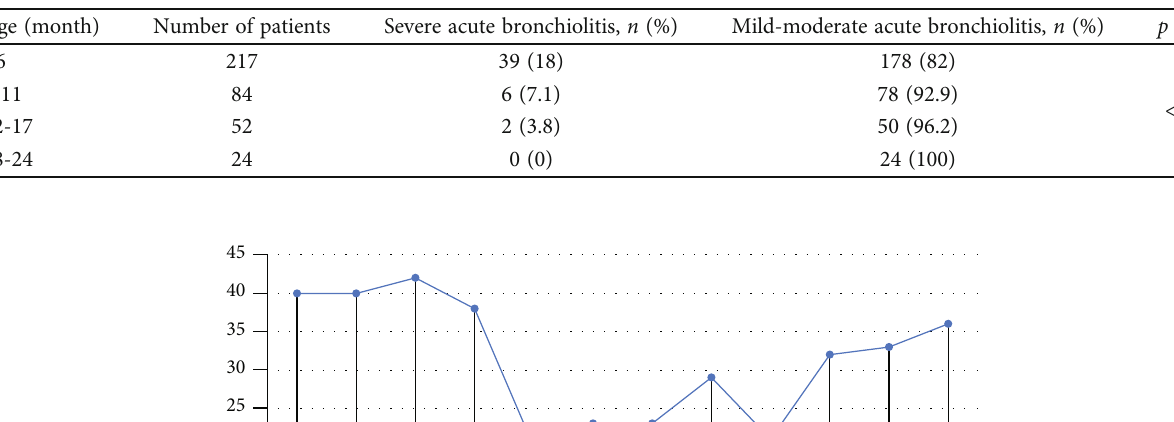
Table 3: The severity of acute bronchiolitis categorized by